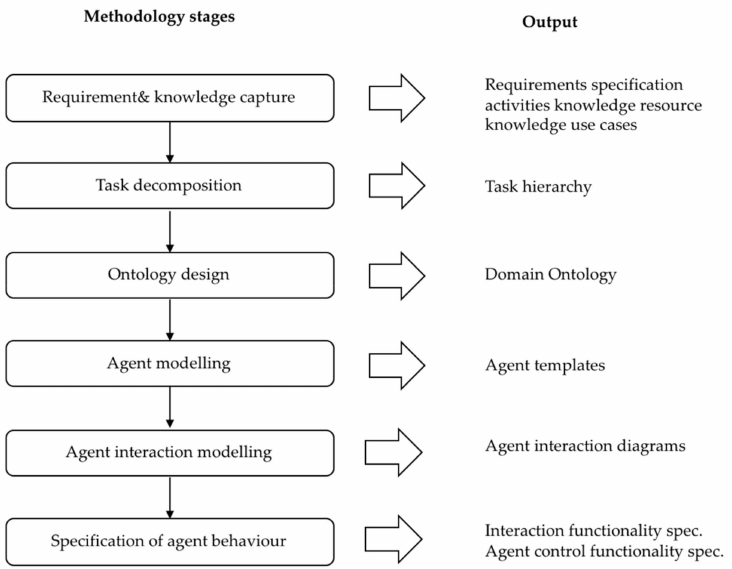
Figure 6. Agent design methodology stages and their output used during the design of the PEDA (Protection Engineering Diagnostic Agents) system